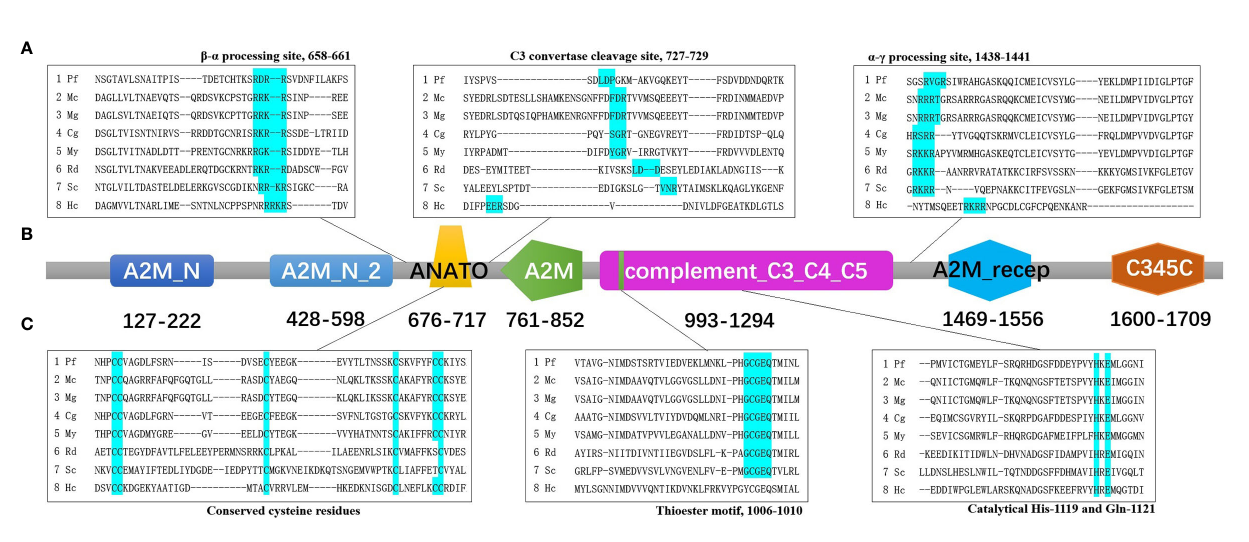
FIGURE 1 | The predicted functional domains and conserved sites of pf-C3. (A) Multiple alignments of partial amino sequences of selected C3 proteins from bivalves to show the vital functional loci of b – a processing site, C3 convertase cleavage site and a – g processing site. (B) The predicted functional domains of pf-C3. A2M_N, A2M_N_2, ANATO, A2M, complement_C3_C4_C5, A2M_recep and C345C domain were marked with colors sequentially. (C) Multiple alignments of partial amino sequences of selected C3 proteins from bivalves to show the vital functional loci of thioester motif and conserved Cys, His, Glu residues. The abbreviations